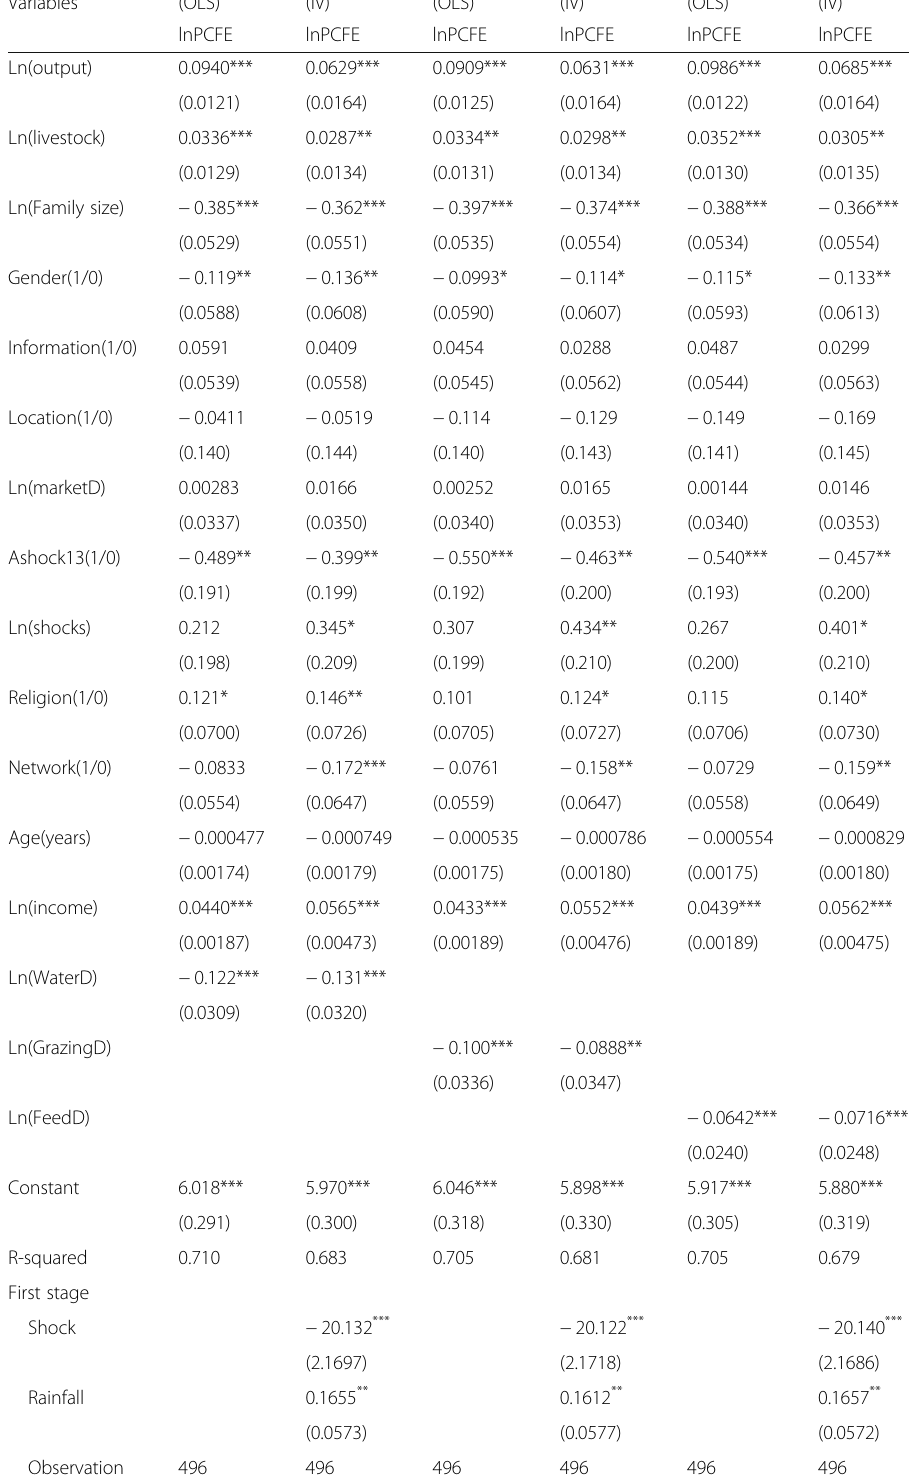
Table 3 IV estimation of log per capita food expenditure using walking distance